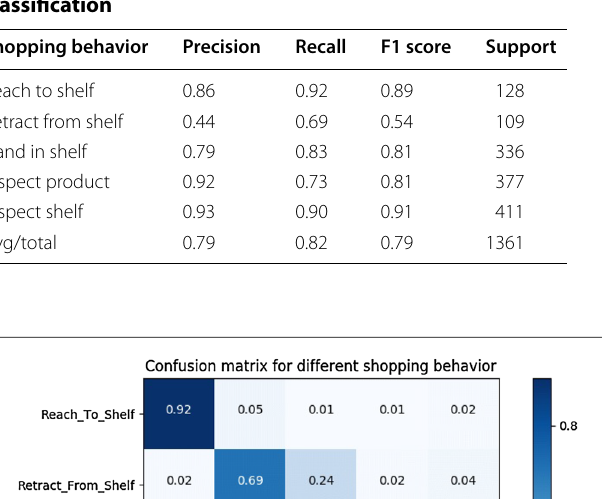
Table 5 Performance evaluation of shopping behavior